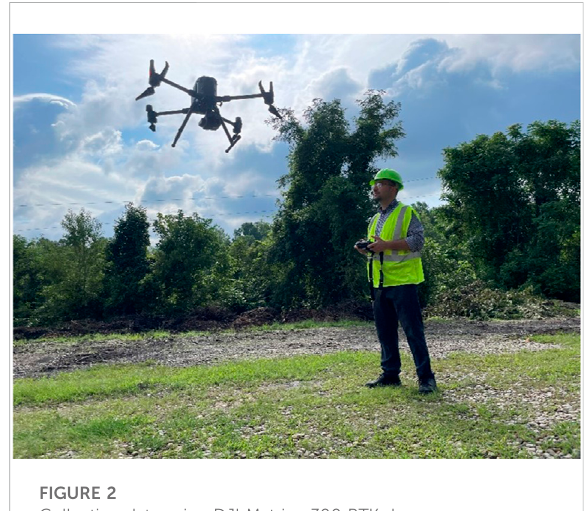
FIGURE 2 Collecting data using DJI Matrice 300 RTK